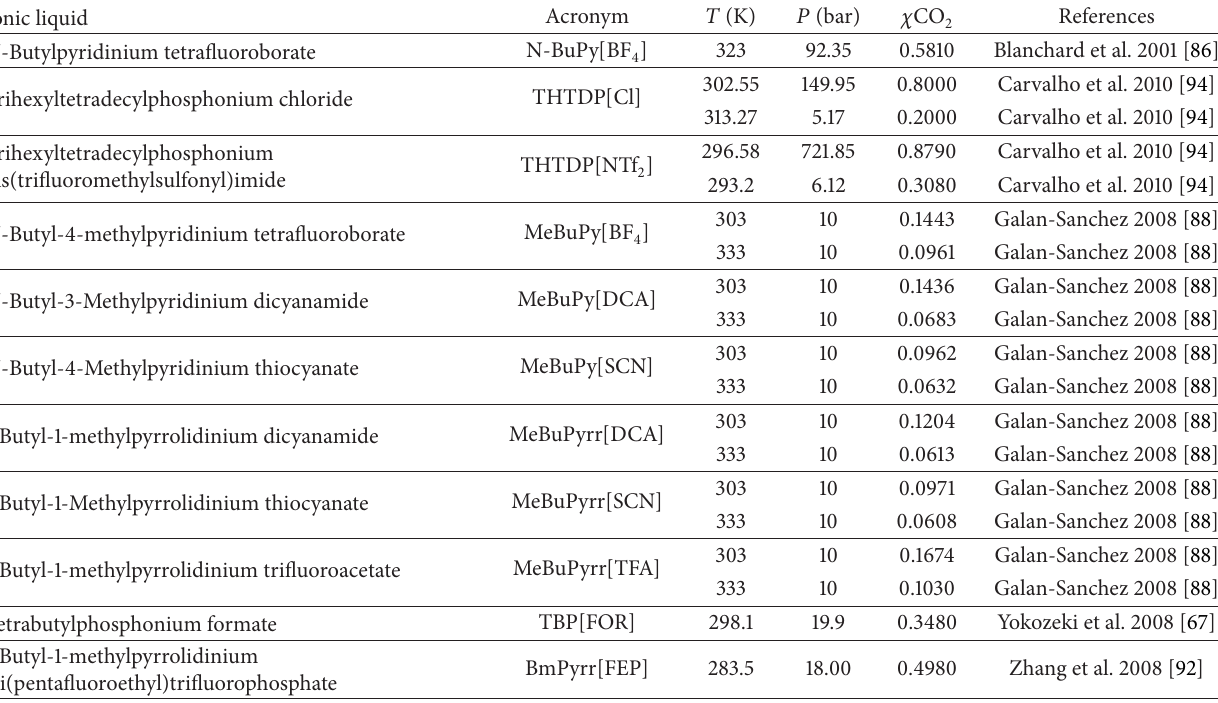
Table 6: CO solubility for phosphonium, pyridinium and pyrrolidinium ionic liquids. 2